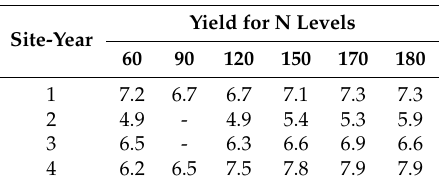
ha − 1 ) for winter wheat ( Triticum aestivum L.) with 14% grain moisture · ha − 1 ) of the four ·